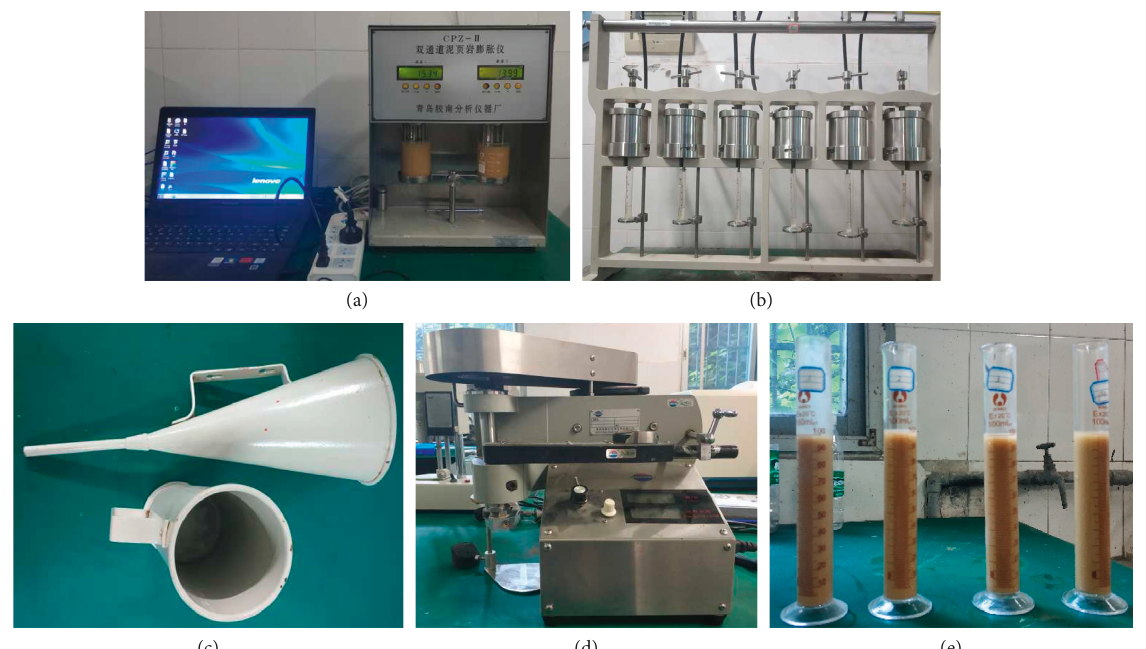
Figure 1: Tests of the slurry properties. (a) Swelling test. (b) Filter loss test. (c) Funnel viscosity test. (d) Lubricity test. (e) Stability